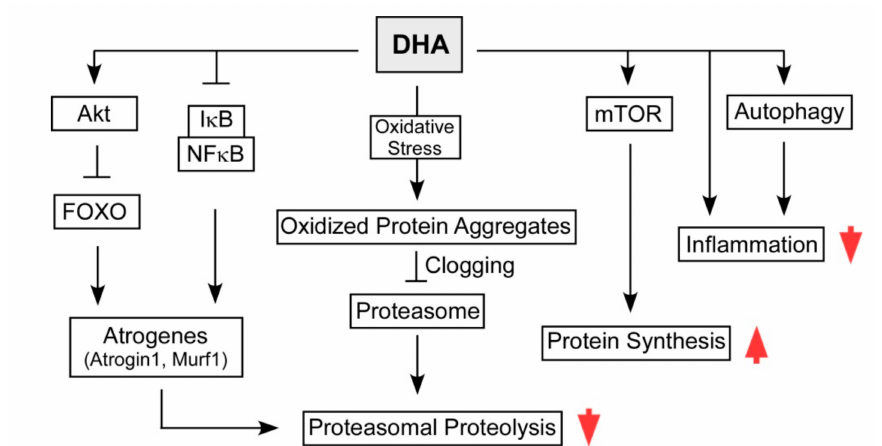
Figure 5. Overview of molecular mechanisms of docosahexaenoic acid (DHA) action potentially improving the skeletal muscle health and function through enhancing protein synthesis and reducing proteolysis and